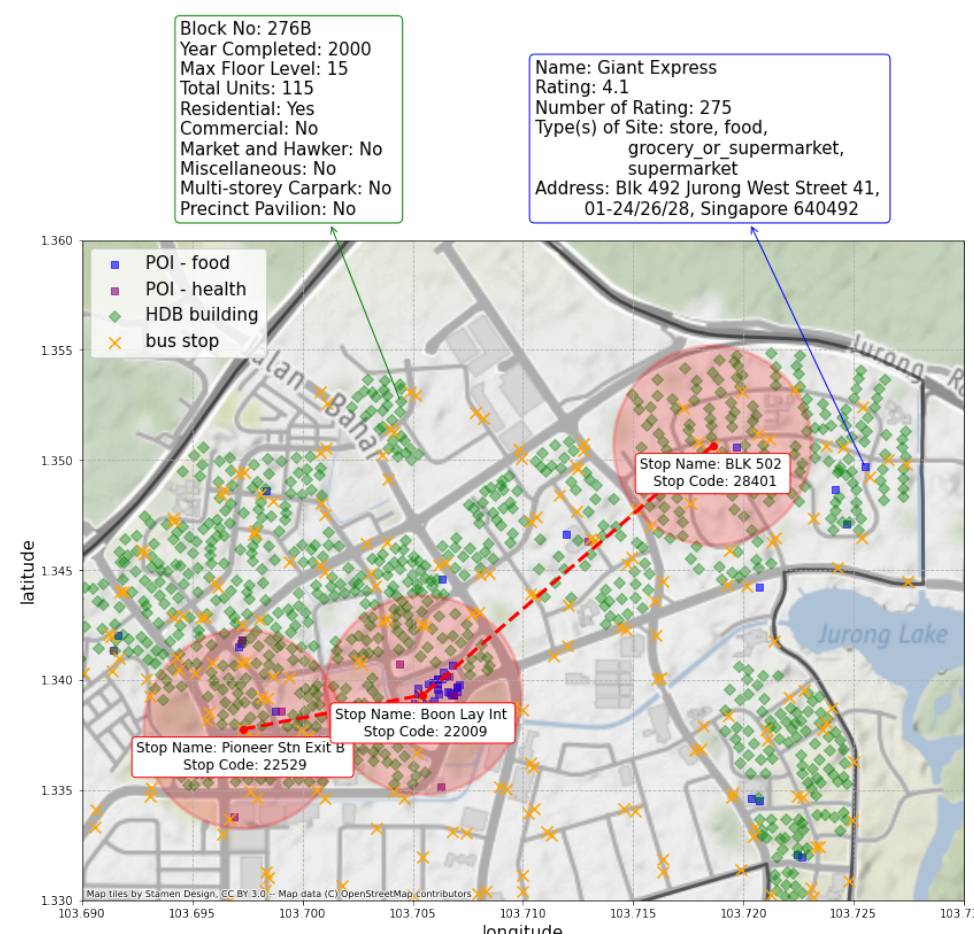
Figure 1. An example of three nodes centered around three bus stations Pioneer Stn Exit B , Boon Lay Int and BLK 502 , as well as the distribution of HDB buildings and POIs in the area. The establishment attributes and coordinates of the HDB building BLK 276B and the POI Giant Express are shown as an example of what they will entail. The radius of the red circles is 500 m. Green diamonds represent HDB buildings, and blue and purple boxes represent POIs of type food and type health , respectively. Best viewed in